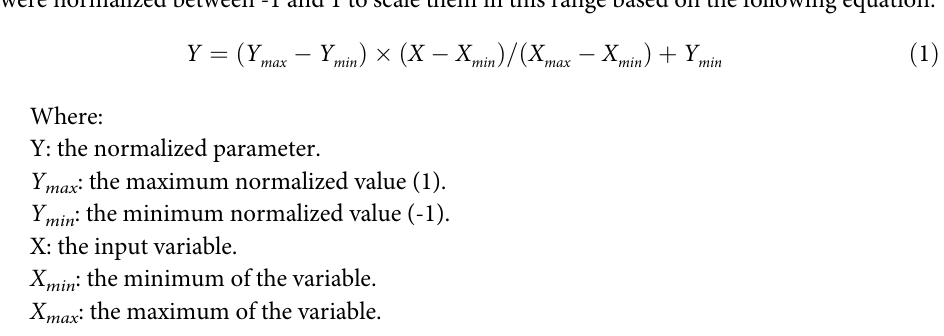
the P indicates that the P can be a moderate function of the γ and the (R) of 0.383 and 0.315 b b g for the API and T proves that the P can be a weak function of the API and T . b f f Before the ANFIS model was applied, the collected data were split into two parts 70% for training the model and 30% for testing the proposed ANFIS model. The statistical description of the training and testing datasets is shown in Table 2. As in the table, the training and testing datasets are at the same ranges to build and evaluate the ANFIS model with the same data ranges. It is essential to avoid the over-fitting and under-fitting issues; data randomization was used to overcome these issues. In addition, all parameters for the training and testing datasets were normalized between -1 and 1 to scale them in this range based on the following equation: